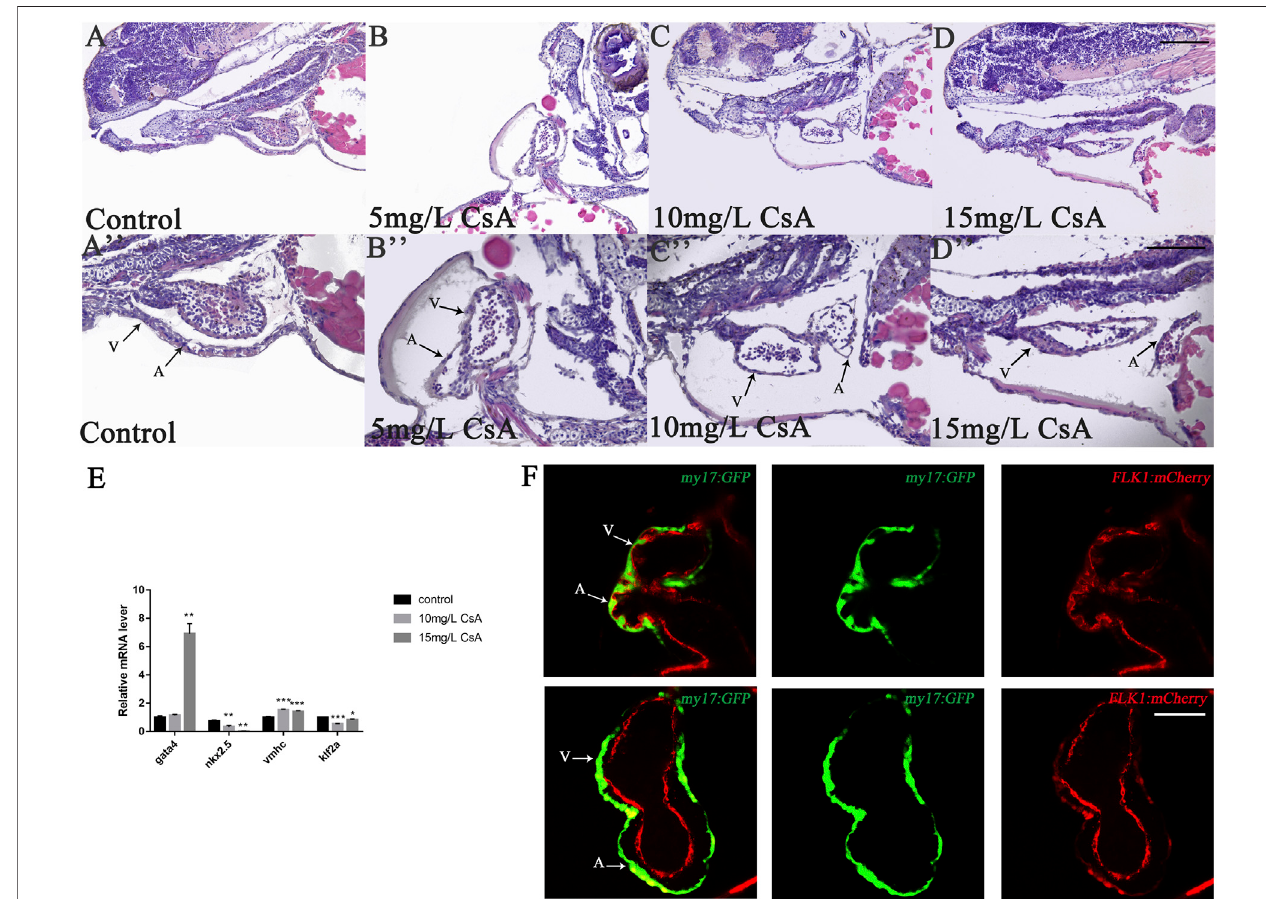
FIGURE2| CsAexposureinducedcardiacdevelopmentdefects. (A-D) HEstainingofheartofzebra fi shat72 hpfexposedto5 mg/L,10 mg/L,and15 mg/LCsA. Magni fi cation: × 200 (top), × 400 (bottom); the black arrows indicated the atria and ventricles; A: atria and V: ventricles (E) The mRNA levels of heart-related genes in the controlgroupandthe15 mg/LCsAexposuregroup(Comparedwithcontrol:* p < 0.05,** p < 0.01,*** p < 0.001,mean ± S.D). (F) Confocalimagesofthecardiac region of the dual transgenic lines Tg (my17: GFP) and Tg ( fl k1: mCherry) in the control and treatment groups. 50 µm (A-D) , 25 µm (A-D) , 50 µm (F) .